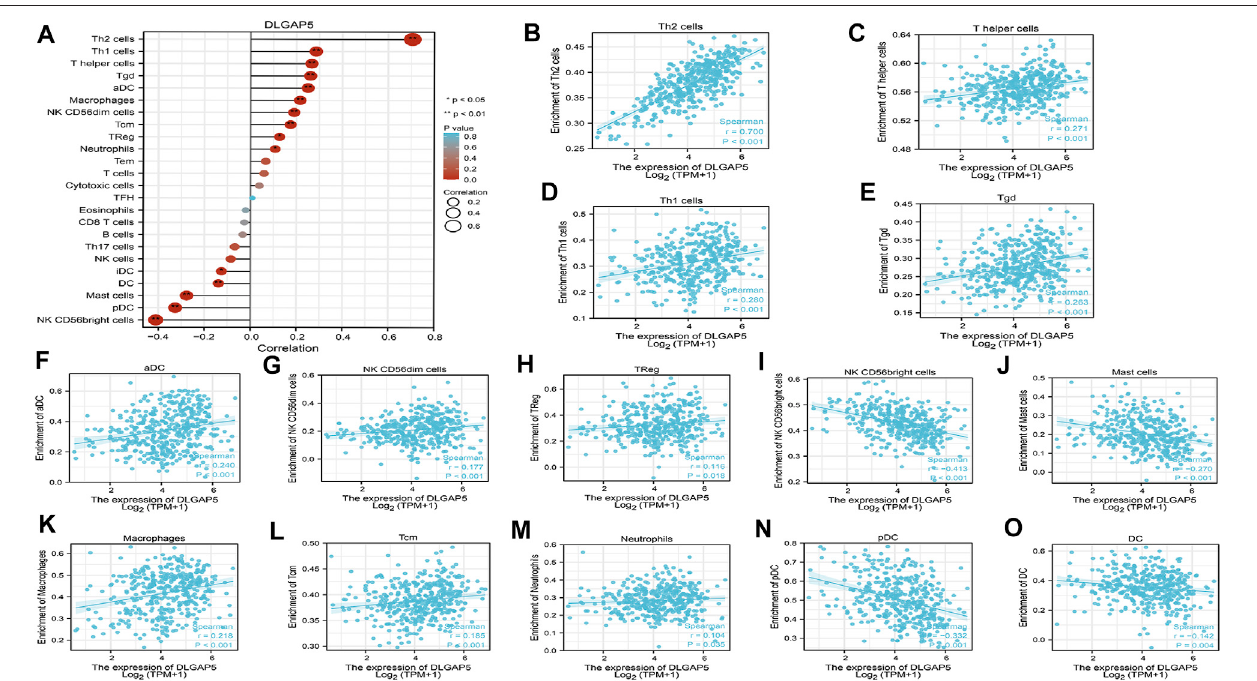
FIGURE 4 | Analysis of immune cell in fi ltration with DLGAP5. (A) a lollipop graph was constructed to show the correlation between DLGAP5 with 24 types of immunecells.Thedifferentdegreecolorofbubblewasonbehalfofthepvalueandthesizeofbubblerepresentedthedegreeofcorrelation.Thelefttermswerenegative correlation and the right terms were positive correlation when p value < 0.05. 0: p < 0.05, a*: p < 0.01. (B) Th2 cells (p < 0.001,1-0.700) (C) T helper cells (p < 0.001, t- 0.271) (D) Thlcells(p < 0.001,1-0.280) (E) Tgd(p < 0.001,r-0.263) (F) aDC(r < 0.001,r=0.240) (G) NKCD56dimcells(p < 0.001,r=0.177) (H) TReg(p=1.018,r =0.116) (K) Macrophages(p < 0.001,1=0.218) (L) Tem(p < 0.01:11,-i=0.185),and (M) Neutrophils(p-1.035,1=0.104)hadpositivecorrelation withDLGAP5. (I) NK CD56bright cells (p < 0.001 (N) pDC (p < 0.001, r = − 0.332) (J) Mast cells (p < 0.001, t = − 0.270) and (O) DC (p = 0.004, r--0.142) had negative association with